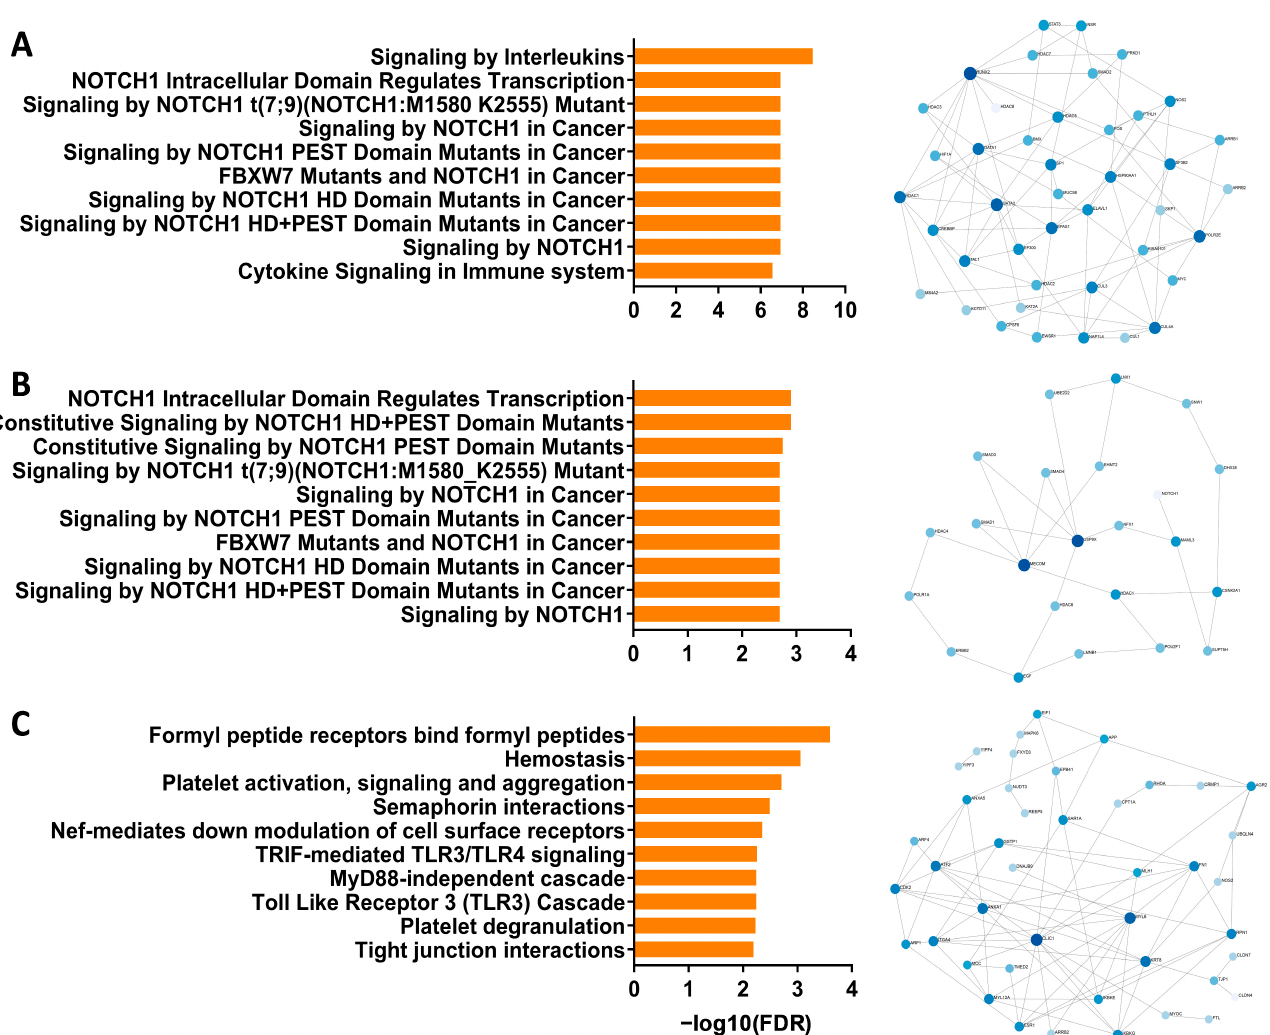
Figure 1. Interrogation of the Notch signaling pathway in published airway epithelial RNA-Seq datasets from children with wheeze. ( A ) Top 10 pathways (reactome) enriched in differentially expressed genes from ex vivo lower airway epithelial samples from children with recurrent wheeze compared to non-wheeze controls. Minimum network map of genes associated with the Notch signaling pathway (reactome) in lower airway epithelial samples from children with recurrent wheeze. ( B ) Top 10 pathways (reactome) enriched in the M14 module associated with Injury Response in ex vivo nasal epithelial samples from an independent cohort of children with high wheeze and low lung function. Minimum network map of genes associated with the Notch signaling pathway (reactome) in the M14 module. ( C ) Top 10 pathways (reactome) enriched in the M20 module associated with Epithelial Integrity in ex vivo nasal epithelial samples from children with high wheeze and low lung function. Minimum network map of genes in the M20 module where there was a lack of association with the Notch signaling pathway. The size of nodes indicates a larger number of gene:gene connections, or high hub degree, and color saturation indicates their betweenness, or centrality value, within the network.